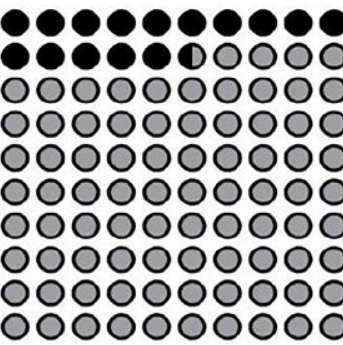
Figure 3 - Prevalence of Attention-Deficit Hyperactivity Symptoms (ADHD) in Children and Adolescents with Lower Urinary Tract Symptoms